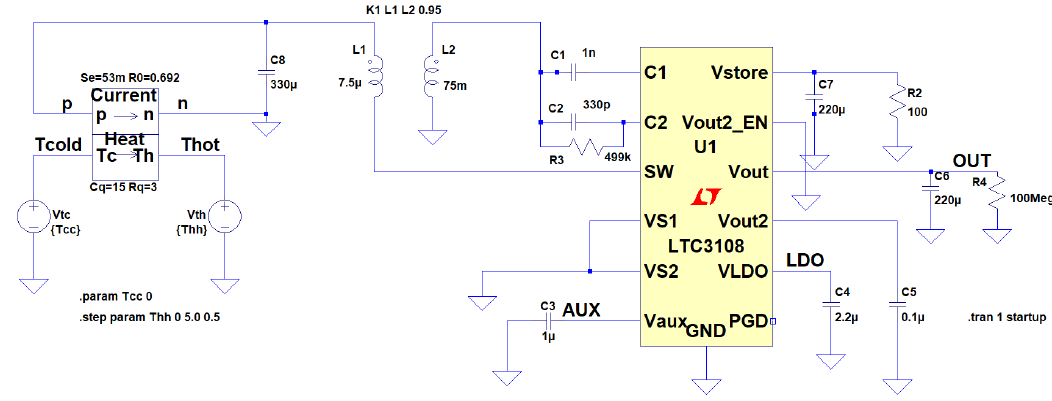
Figure 3. Thermal Energy Harvesting Circuit of TEC1-12722 with LTC3108 PMIC.